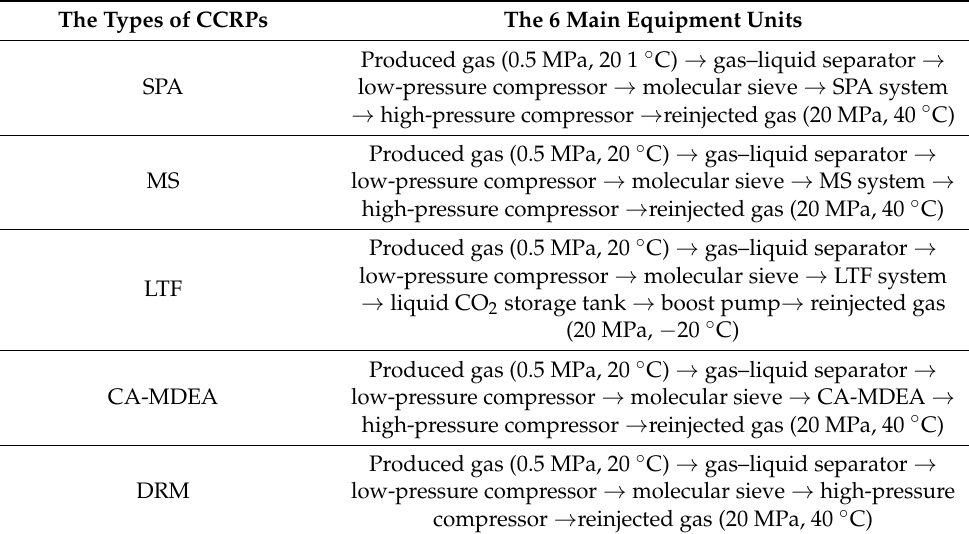
Table 1. Main equipment units involved in the five types of